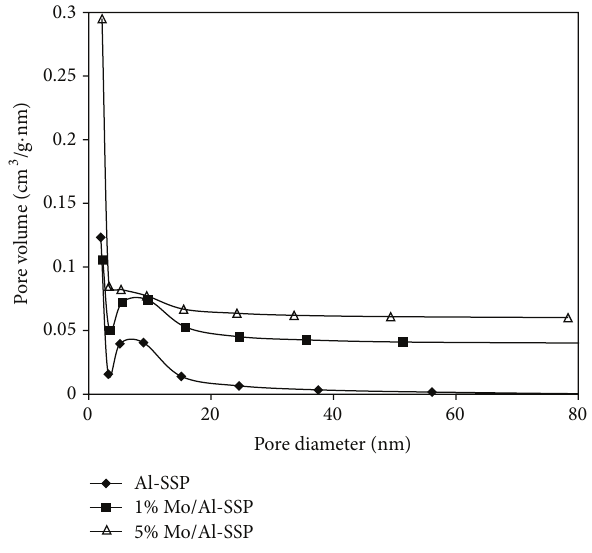
Figure 3: BJH pore size distribution of all